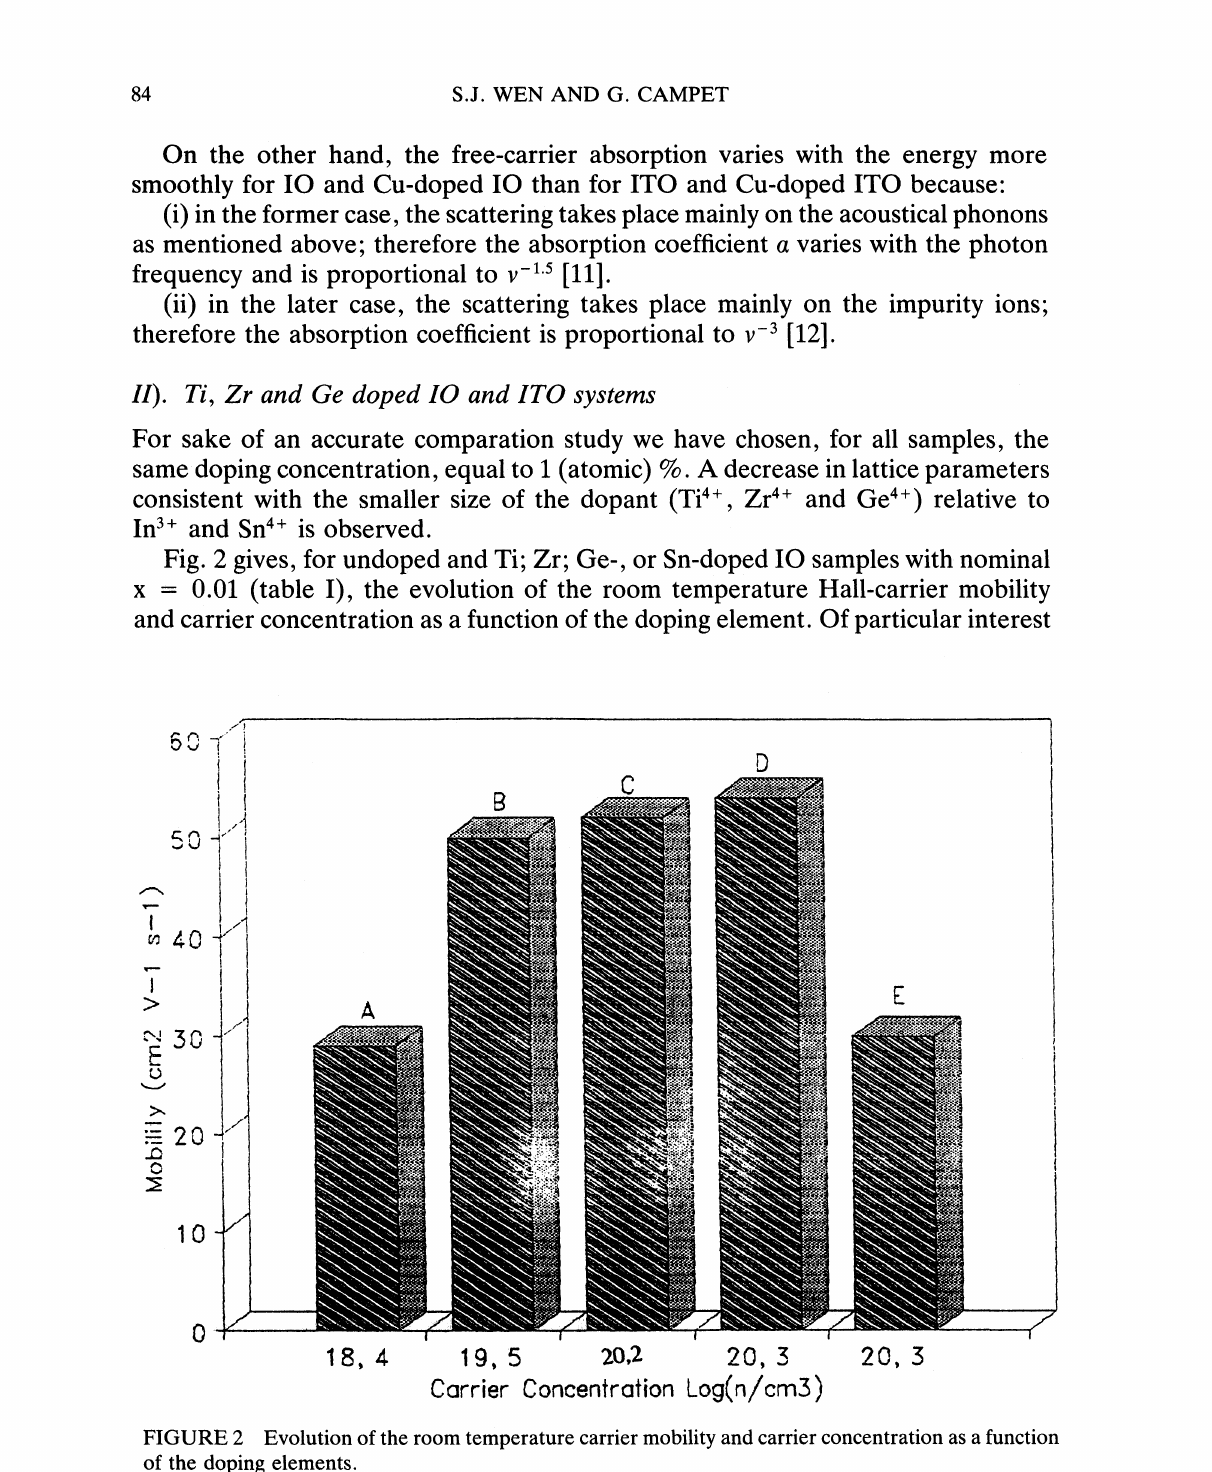
FIGURE 2 Evolution of the room temperature carrier mobility and carrier concentration as a function of the doping elements. A IO, B IZO, C ITiO, D IGO, E ITO. For all samples: M/(In + M) 0.01, and here M is Ti, Zr, Ge and